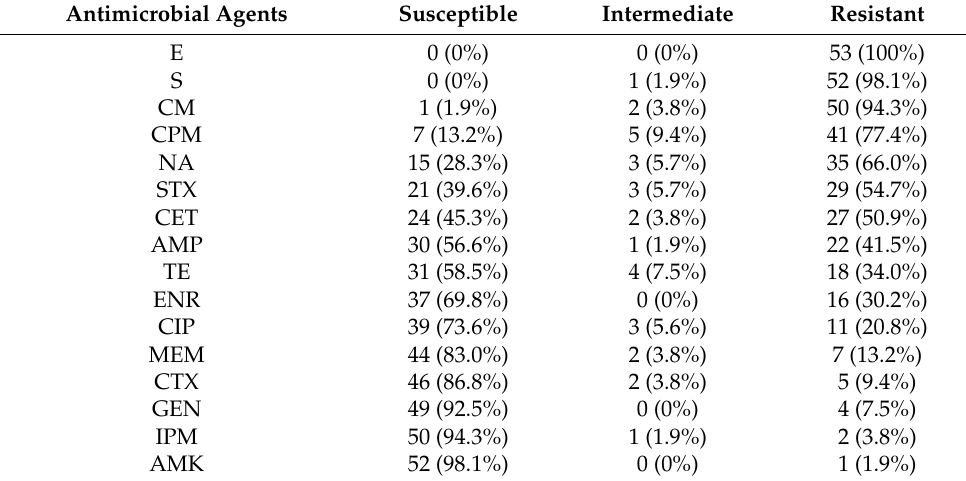
Table 2. Number and (%) of antimicrobial resistant/susceptible Salmonella strains ( n = 53) isolated from the investigated buffalo meat